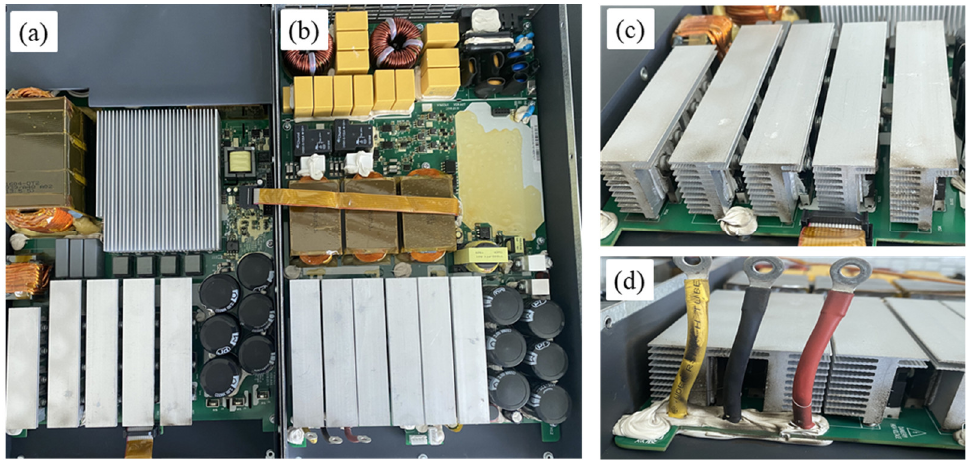
Figure 5. No. 2 power module interior photo after 9 months of use: ( a ) power module front; ( b ) power module rear; ( c ) front heat sink; ( d ) rear heat sink.